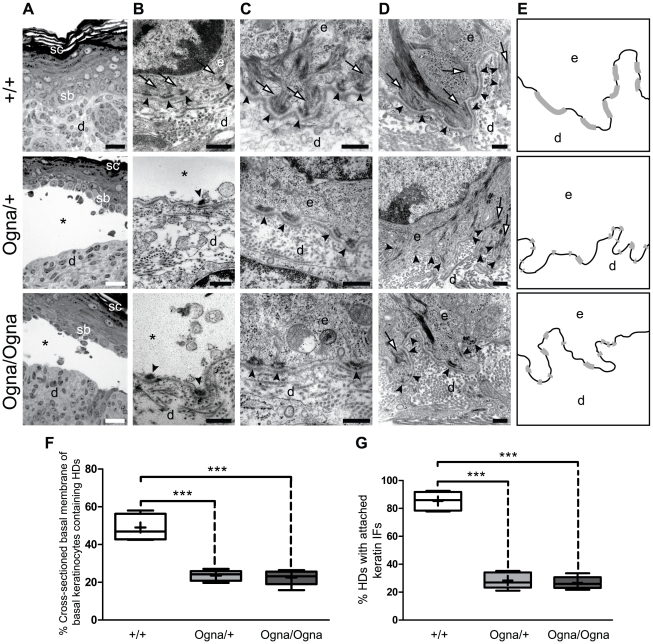
Histological and ultrastructural abnormalities of Ogna mouse skin.(A) Epoxy resin-embedded and toluidine blue-stained skin sections from 1-day-old mice. Asterisks indicate trauma-induced blister formation between stratum basale (sb) and dermis (d), not observed in Plec
+/+ mice. sc, stratum corneum. (B) Transmission electron microscopy of skin lesions. Arrowheads indicate intact HDs with attached keratin filament bundles (arrows) aligned along the basal cell membrane of basal keratinocytes in wild-type skin, and remnants of HDs lacking keratin filaments at blister (*) floors in mutant skin. (C,D) High magnification electron micrographs of intact skin sections of newborn (C) and adult (D) mice. (E) Outlines of HDs (grey bars) distributed along the basal cell membrane of basal keratinocytes (black lines) in panels D. Note reduced numbers and smaller sizes of HDs (arrowheads in C and D) in mutant, compared to Plec
+/+ skin; also, few HDs in mutant skin have attached keratin filament bundles, whereas thick bundles of filaments attached to HDs are dominant in Plec+/+ skin (arrows in C and D). d and e (B–E), dermis and epidermis, respectively. Bars, 20 µm (A); 500 nm (B–D). (F,G) Morphometric analysis of HD numbers (average percentage of cross-sectioned basal cell membrane of basal keratinocytes containing HDs) (F) and keratin filament attachment (G) in adult mouse skin. A total length of 55–60 µm of basal cell membrane of basal keratinocytes was analyzed in electron micrographs of foot pad skin sections from wild-type and mutant littermates (n = 5, total numbers of HDs scored: Plec+/+, 617; PlecOgna/+, 590; PlecOgna/Ogna, 605). Box and whisker plots indicate the median (middle line in the box), the mean (small crosses), 25th percentile (bottom line of the box), 75th percentile (top line of the box), and 2.5th and 97.5th percentiles (whiskers). *** P<0.001, one-way ANOVA with Tukey post test for multiple comparisons.